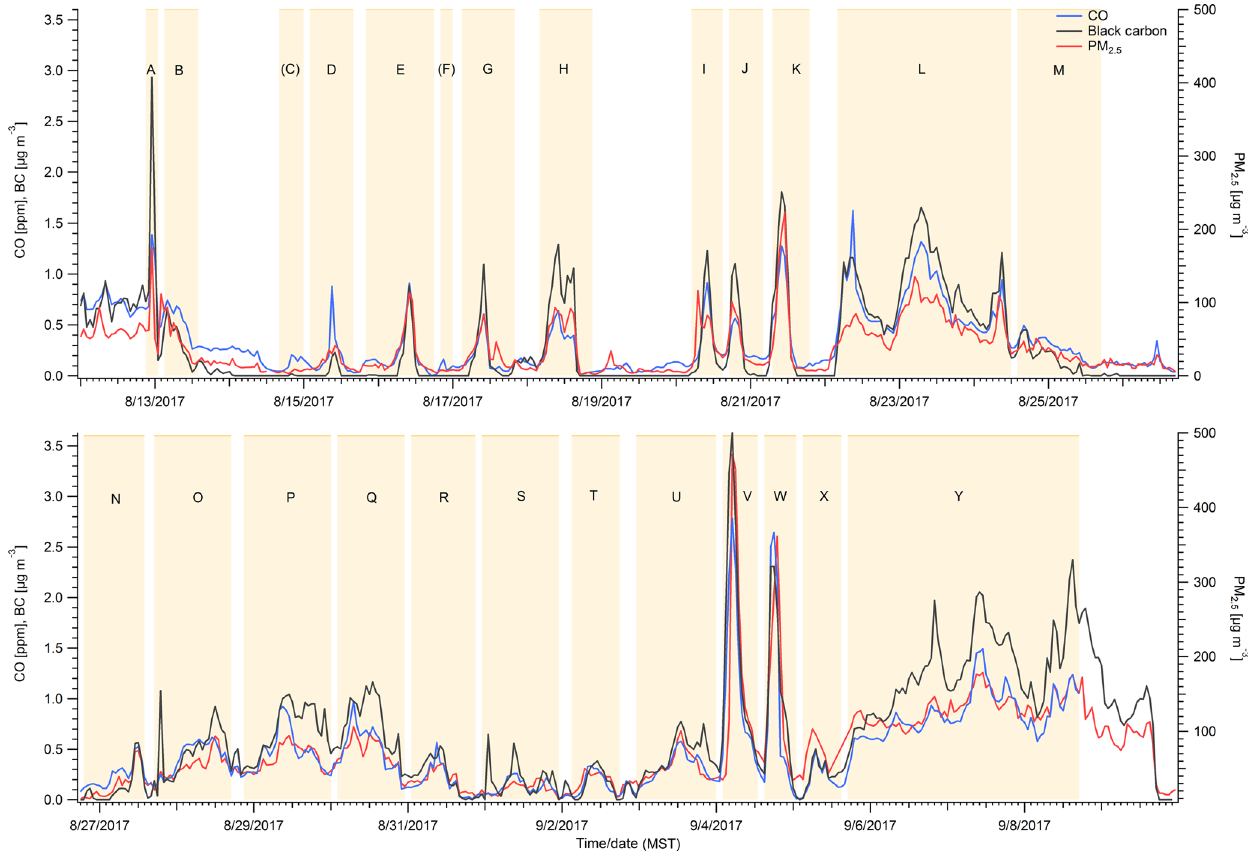
Figure 1. Time series of hourly CO, BC, and PM 2 . 5 measurements from Missoula. Sections highlighted in yellow roughly indicate smoke- impacted periods. A few small peaks that could not be attributed to biomass burning sources were excluded from